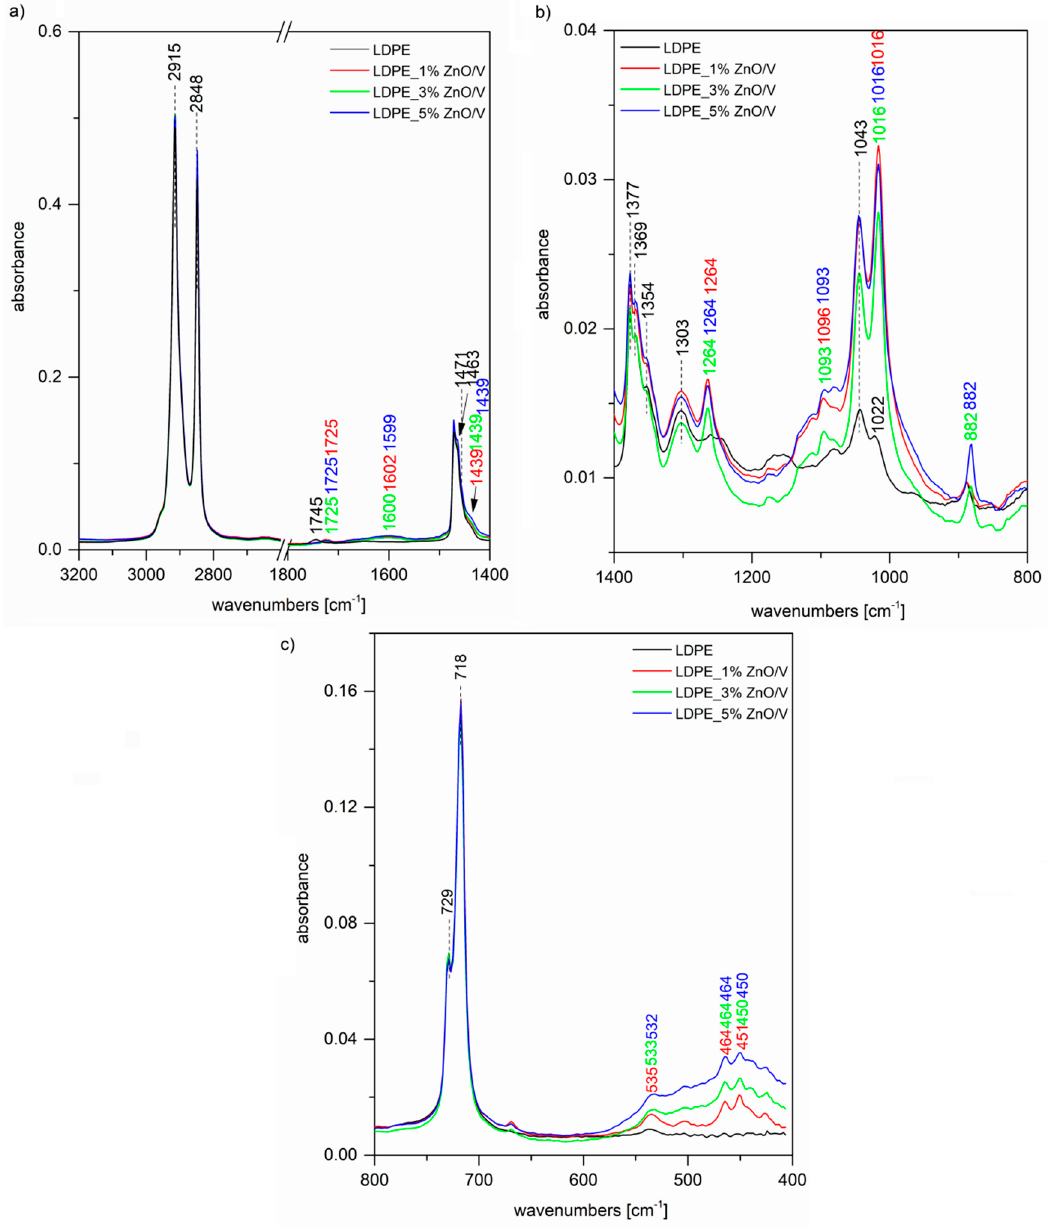
Figure 4. FTIR spectra of the original LDPE and LDPE_ZnO / V nanocomposite plates at regions ( a ) 3200–1400 cm − 1 , ( b ) 1400–800 cm − 1 and ( c ) 800–400 cm − 1 .